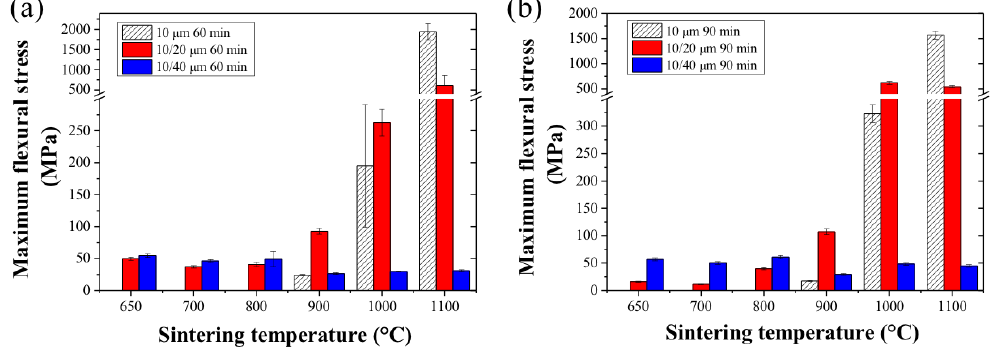
Figure 7. Maximal flexural stress of the SS HFs as a function of the sintering temperature with ( a ): HFs sintered for 60 min and ( b ): HFs sintered for 90 min.